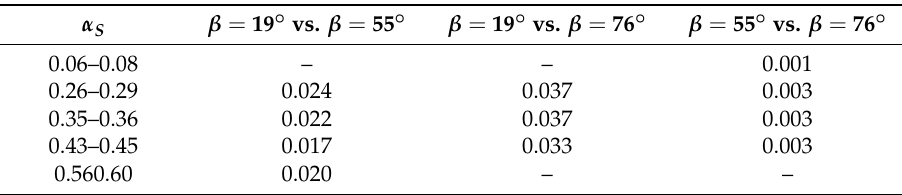
Table 5. Scots pine canopy hemispherical-directional reflectance factor (HDRF) spectral divergence (SID) for different ranges of sunlit fraction.